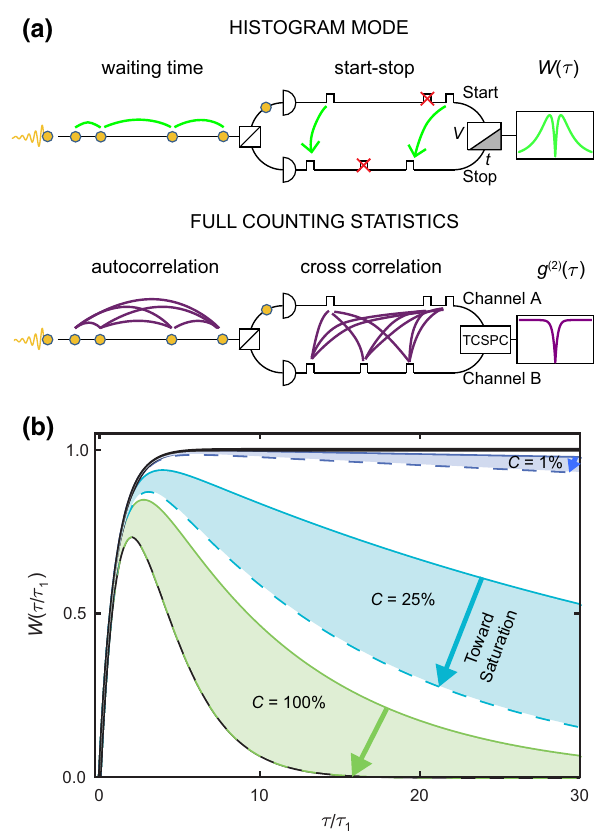
FIG. 2. A comparison of the histogram mode and the full counting statistics. (a) A schematic depicting the experimental setup for measuring the histogram mode and the full counting statistics. A snapshot in time shows photons and electric pulses traveling left to right. A beam splitter directs the photon stream into two separate detectors (semicircles), each of which corre- sponds to a channel. In histogram mode, one channel acts as a start pulse for a ramp circuit and the other is a stop pulse. Additional start (stop) pulses that occur before (after) the stop (start) pulse are neglected. For the full counting statistics, a time-correlated single-photon counter (TCSPC) tags the absolute times of photon arrivals at each channel. (b) The effect of collec- tion efficiency and pump rate on the shape of the waiting-time distribution for a two-level system. The collection efficiency is represented by differently colored shaded regions and the pump rate relative to the emission rate is represented on a spectrum from solid [maximally different pump and emission rates ( α → 1)] to dashed [pump rate = emission rate ( α = 0)] lines. The solid black curve represents g ( 2 ) (τ/τ 1 ) . The dashed black curve repre- sents the waiting-time distribution at unity collection efficiency and equal pump and emission rates, at which point it is the far- thest from approximating g ( 2 ) (τ) . The traces are normalized by the pump rate and collection efficiency for ease of